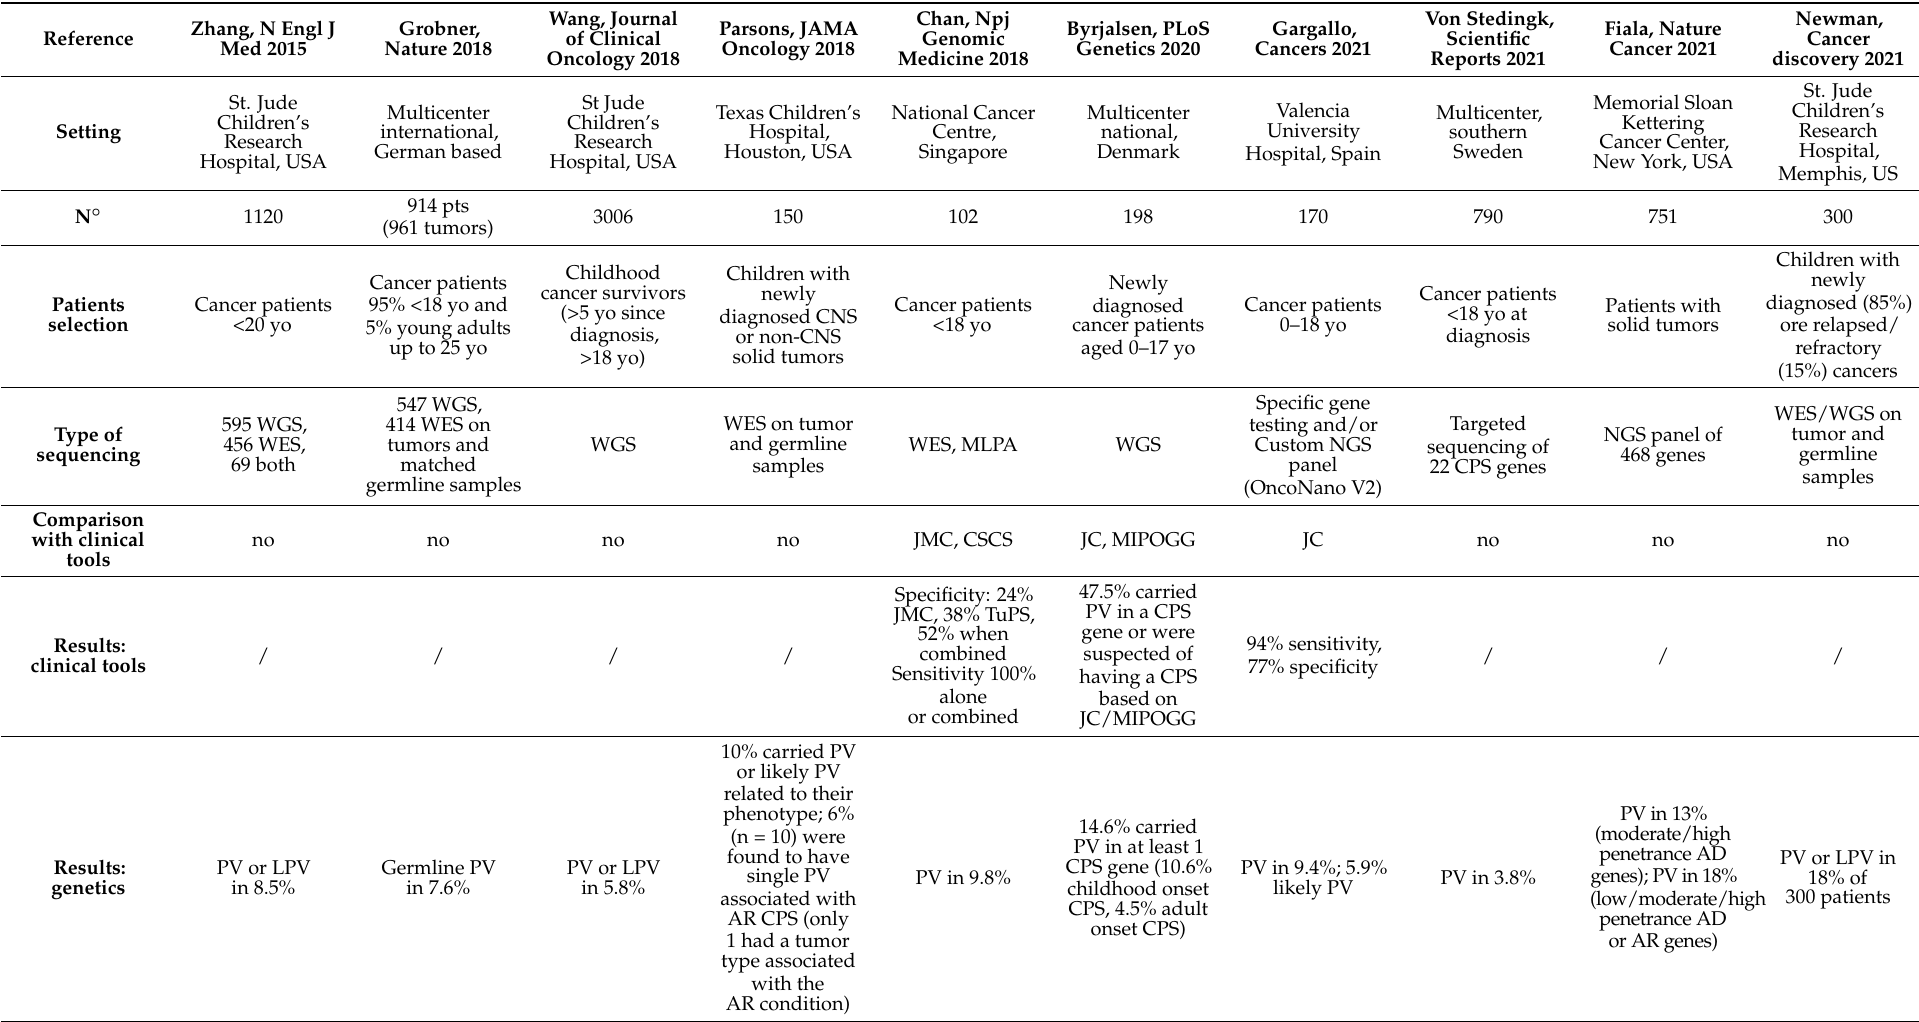
Table 1. CPS prevalence